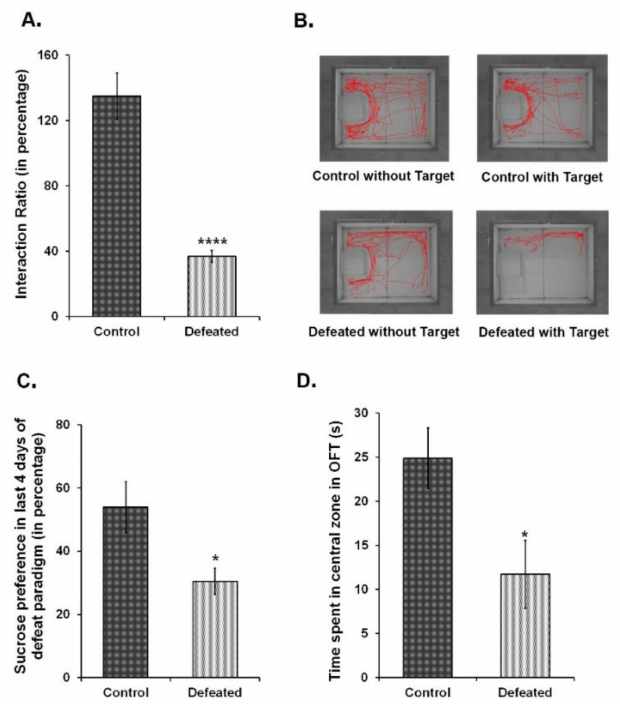
Figure 1. Ten days of chronic social defeat stress induce depression and anxiety-like phenotype in mice. ( A ) Interaction ratio {time spent in the interaction zone in presence of target CD1 (aggressor) mouse in (s) / time spent in the interaction zone in absence of target mouse in (s)} of the control and the defeated C57BL / 6NCrl mice in the social interaction test. ( B ) The track plots of the control and defeated mouse in the presence and absence of the target CD1 mouse during 5 min of social interaction test. ( C ) Percentage consumption of 2% sucrose in the last four days of the chronic social defeat stress (CSDS) paradigm. ( D ) Time spent in (s) in the central zone during open field test (OFT) ( n = 8–10 / group). * p < 0.05 and **** p <